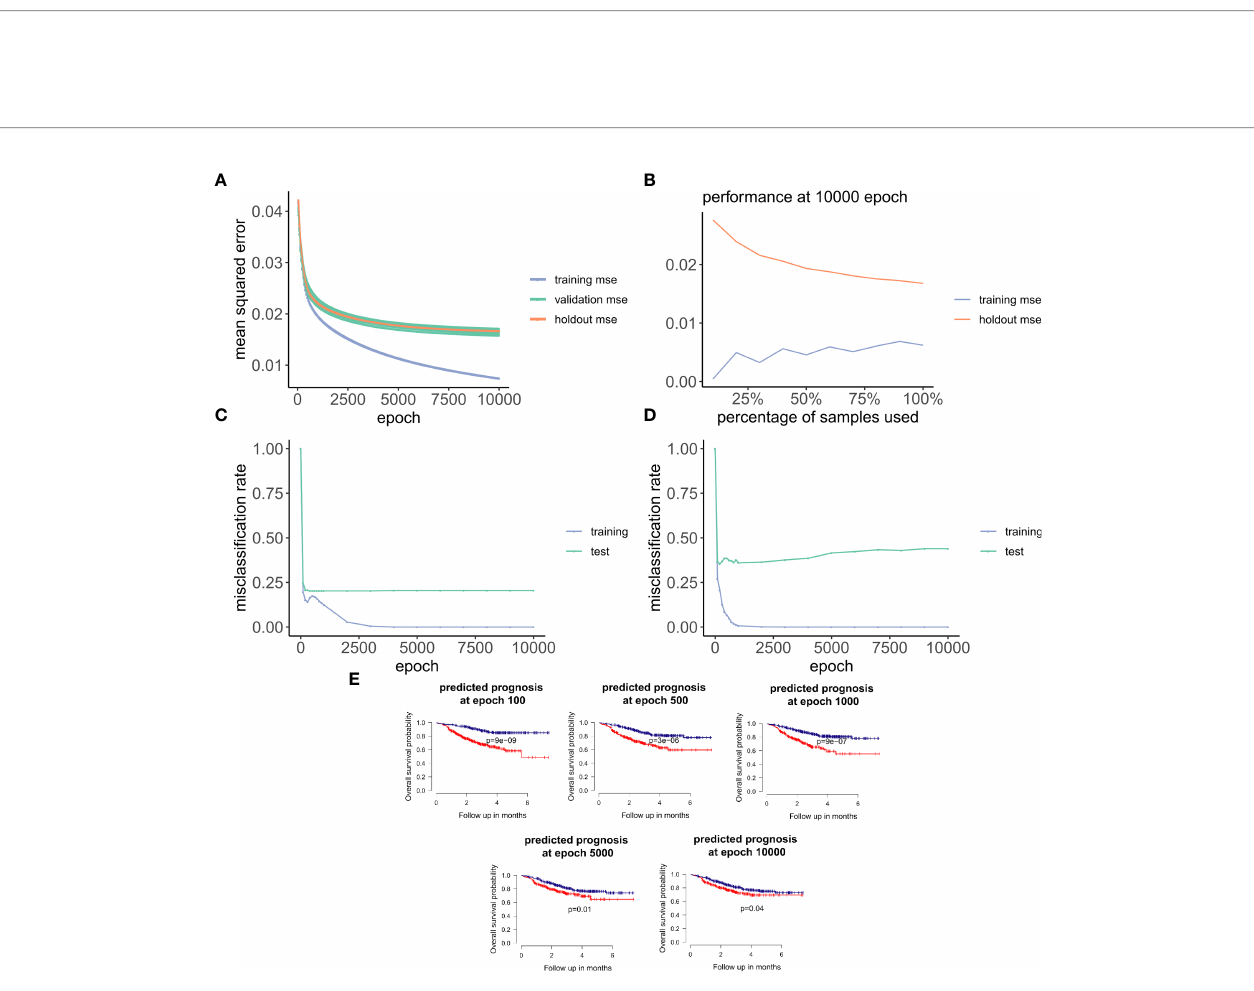
FIGURE 5 | Training and evaluation for models trained with nonlinear ELU activation function. (A) Training curve showing that the mean-squared-error (MSE) of training, and holdout sets improves with training. (B) Change of training and holdout set performance with different training sample sizes, at 10000 epochs. (C, D) Performance of class prediction in misclassi fi cation rates for chemo-sensitive and resistant (pCR and RD) and prognosis (good and poor) improves within training. (E) Kaplan-Meier overall survival plots for poor and good breast cancer prognosis groups with varying number of trained epochs:100, 500, 1000, 5000, and